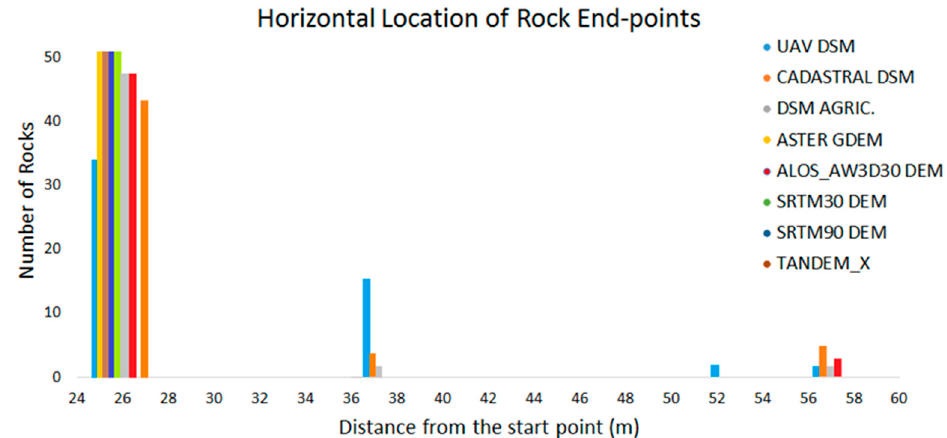
Figure 16. Horizontal location of rock end points for the 2nd slope profile.